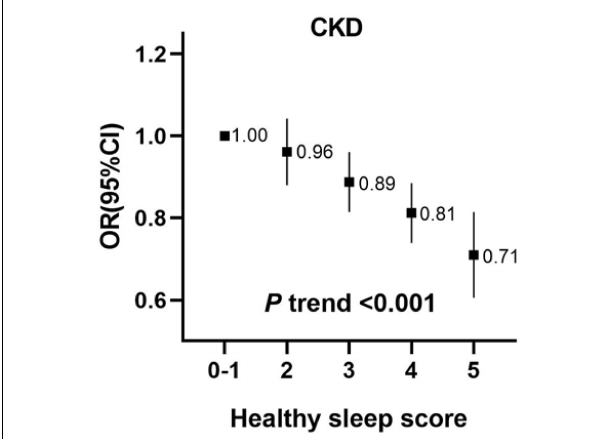
FIGURE 1 | Incident risk of CKD according to healthy sleep score among 370,671 participants. The vertical line indicates the reference value of 1. Multivariable model was adjusted for age, sex, ethnicity (White/others), education (university or college degree/others) and the Townsend index (continuous), smoking status (current, ever, never), drinking status (drinks, continuous variable), physical activity (at goal or not), overweight and obesity (BMI ≥ 25 kg/m 2 ), systolic blood pressure, diabetes (yes/no), use of blood pressure-lowering medications (yes/no) and use of diabetes medications (yes/no). CKD, chronic kidney disease; CI, confidence interval; OR, Odds